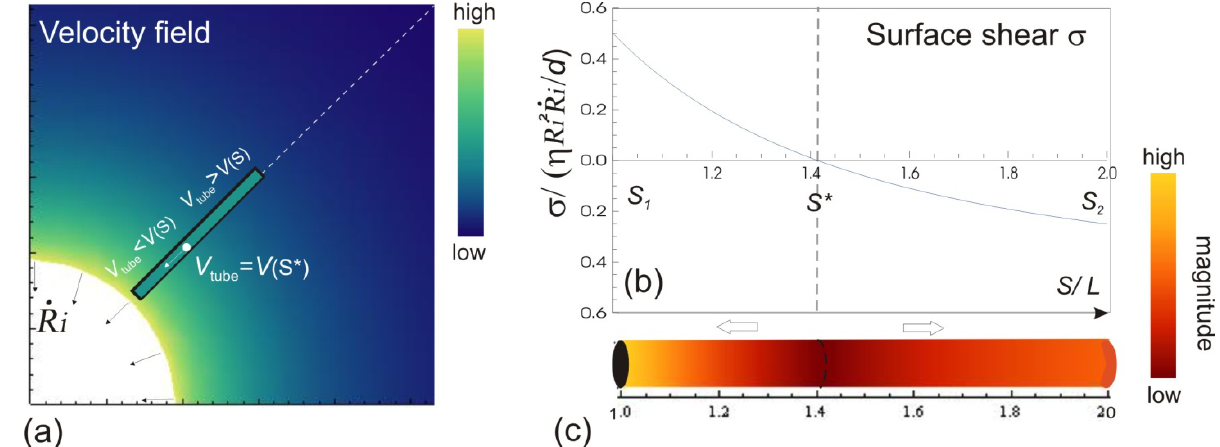
Figure 3. ( a ) A snapshot during the cavitation process, showing a bubble of radius R i R & . The instantaneous velocity field of the fluid medium collapsing with its wall velocity i is illustrated, of which magnitude is indicated by the color-coded surrounding the bubble V s along its scale bar. The filament immersed in the flow can only have a single velocity V tube entire length, hence local surface shear stresses σ are created. The variation of σ w.r.t the s s position on the filament are shown in ( b ) and ( c ). The values of the surface stresses are normalized against the position-independent parameters, and the distance is normalized against the length of the